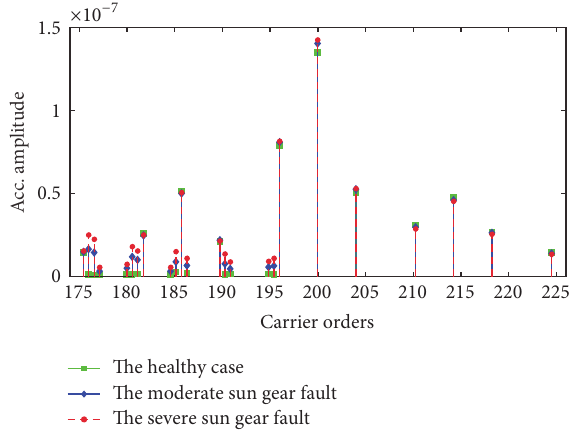
Figure 10: The processed spectrum after the proposed diagnostic